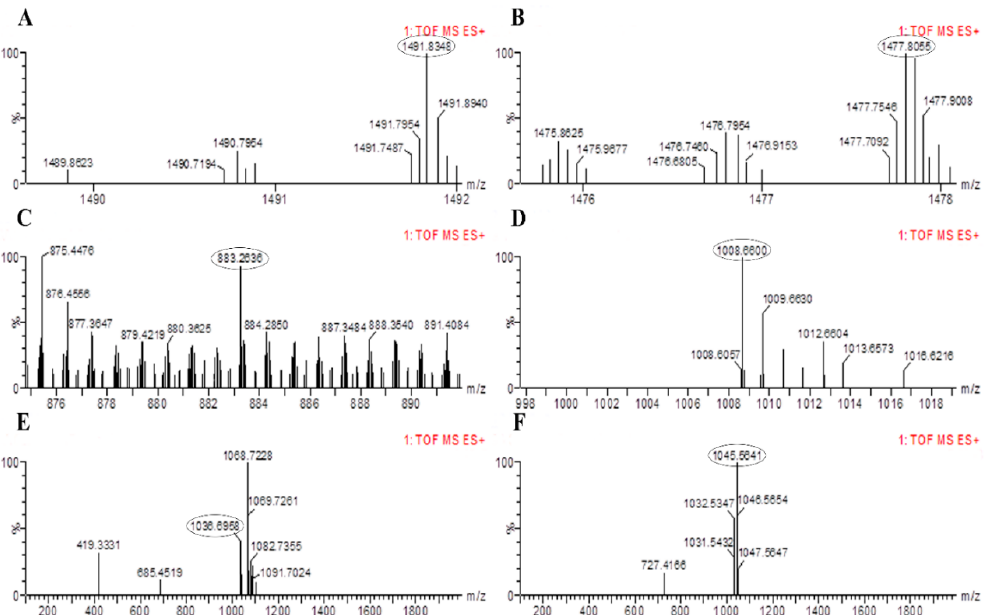
Figure 5. LC-MS chromatogram of methanolic extracts of B. altitudinis HNH7. ( A , B ) = Fengycin; ( C ) = Bacillibactin; ( D , E )= Surfactin and ( F ) = Bacillomycin.